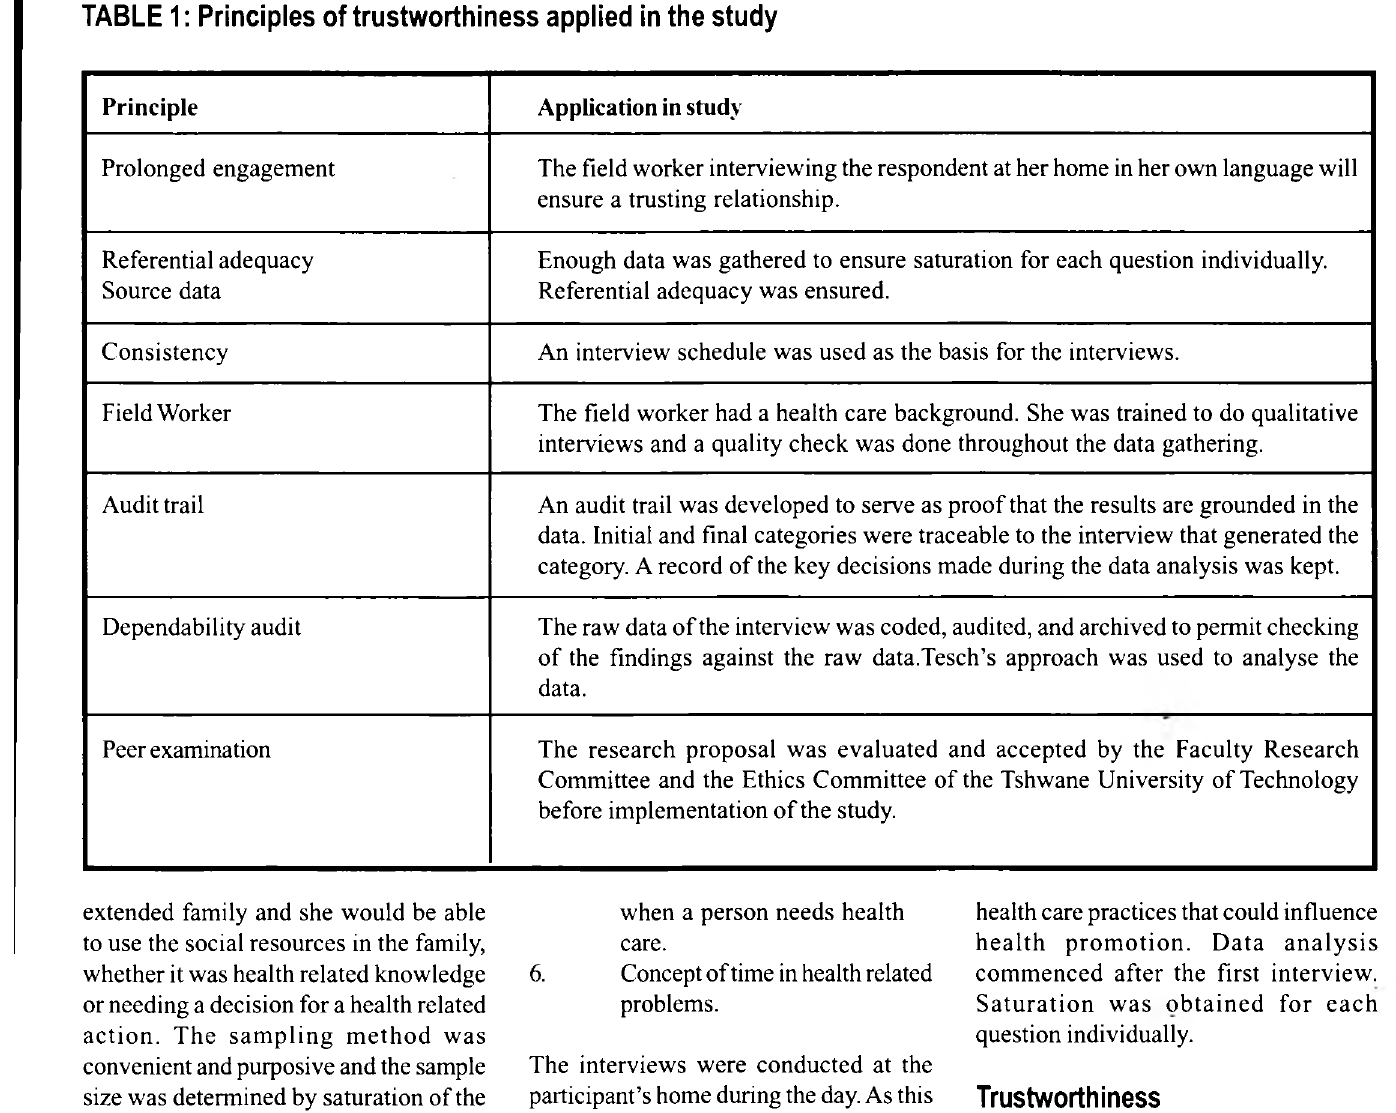
TABLE 1: Principles of trustworthiness applied in the study